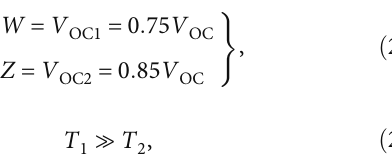
algorithm as presented in the fl owchart of Figure 7, to con- trol the gate of the transistor as shown schematicaly in Figure 8.